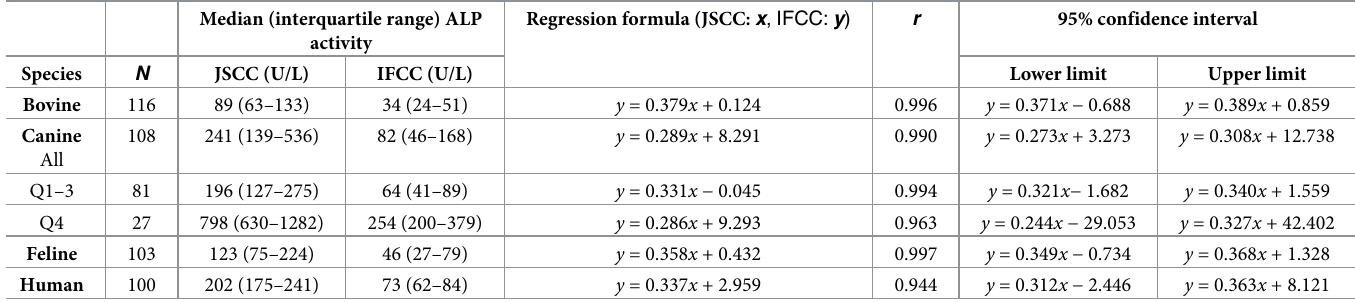
Table 2. Regression analyses between the JSCC and IFCC methods in bovine, canine, feline, and human blood samples. Median (interquartile range) ALP